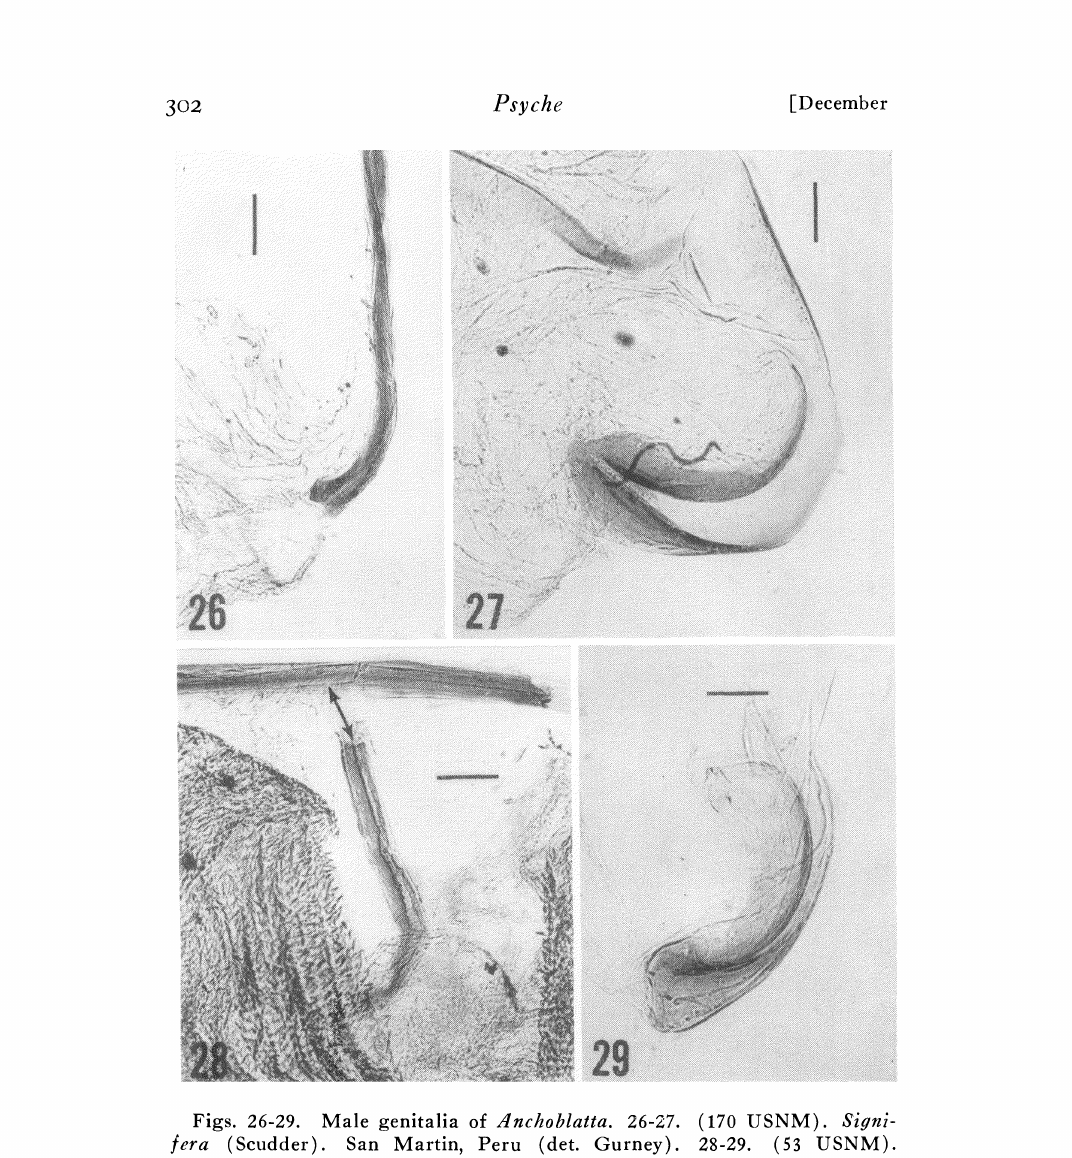
Figs. 26-29. Male genitalia of lnchoblatta. 26-27. (170 USNM). SiTni- fera (Scudder). San Martin, Peru (det. Gurney). 28-29. (53 USNM). Rio Ucuyali, Pucallpa, Peru (det. Gurney). (L2vm was accidentally broken [arrows indicate the two parts of the sclerite]). (scale 0.1